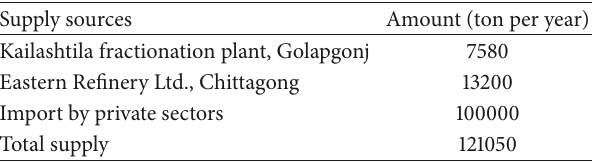
Table 1: Potentials of LPG in Bangladesh [16,